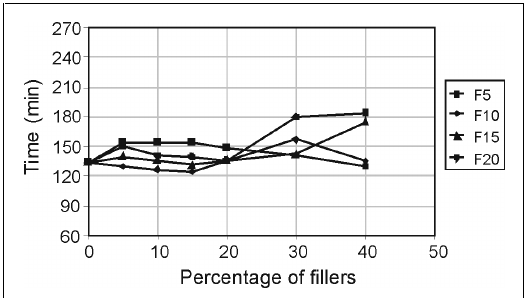
Fig. 3. Consistencies of the cement paste as function of percentage of substitution